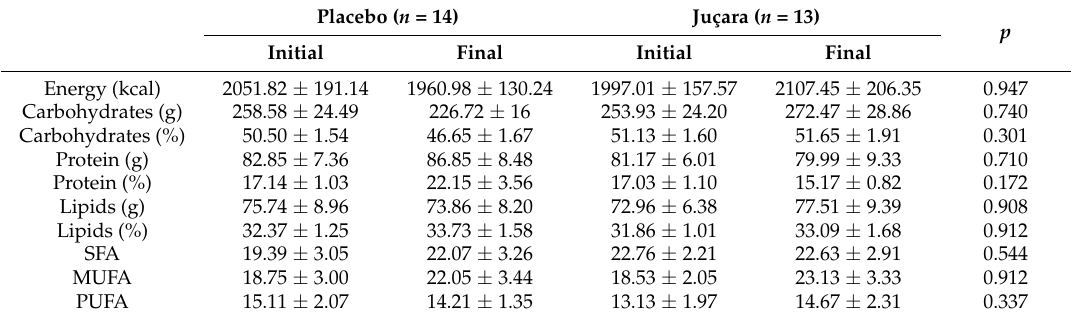
Table 3. Dietary intake before and after the 6-week treatment period.